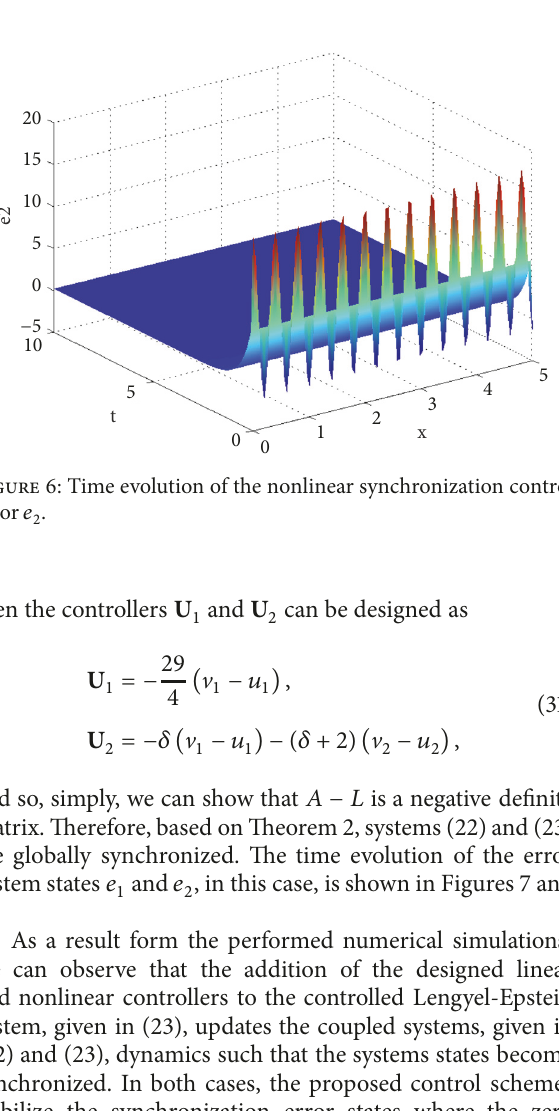
Figure 5: Time evolution of the nonlinear synchronization control error 𝑒 1 .